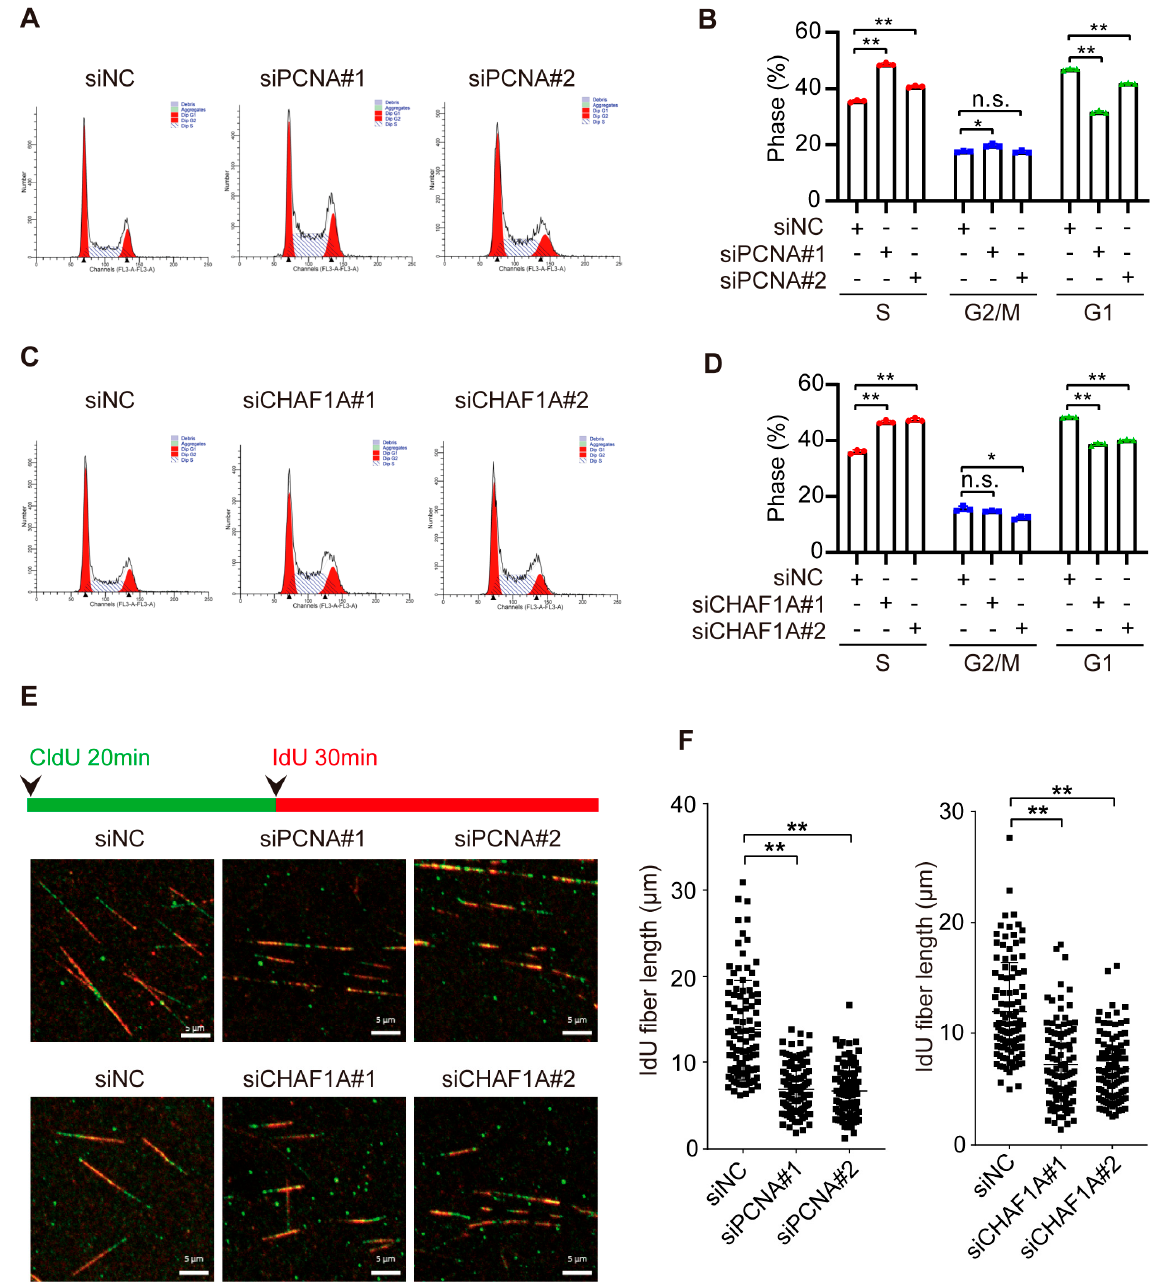
Figure 4. CHAF1A and PCNA facilitate DNA replication in EC cells. ( A , C ) Flow cytometry analysis of the cell cycle (left panel) and ( B , D ) S–phase quantification (n = 3; right) in KYSE30 cells transfected with siNC, siPCNA, or siCHAF1A. ( E ) Schematic of alternative 5–chloro–2–deoxyuridine (CldU)/5–iodo–2–deoxyuridine (IdU) pulse–labeling protocol to evaluate fork length in KYSE30 cells transfected with siNC, siPCNA, or siCHAF1A. ( F ) Representative images and scatterplots of IdU tract length for individual forks (n = 100). Flow cytometry analysis of the cell cycle was performed using ModFit software. * p < 0.05, ** p < 0.01, n.s.: non − signi fi cance.